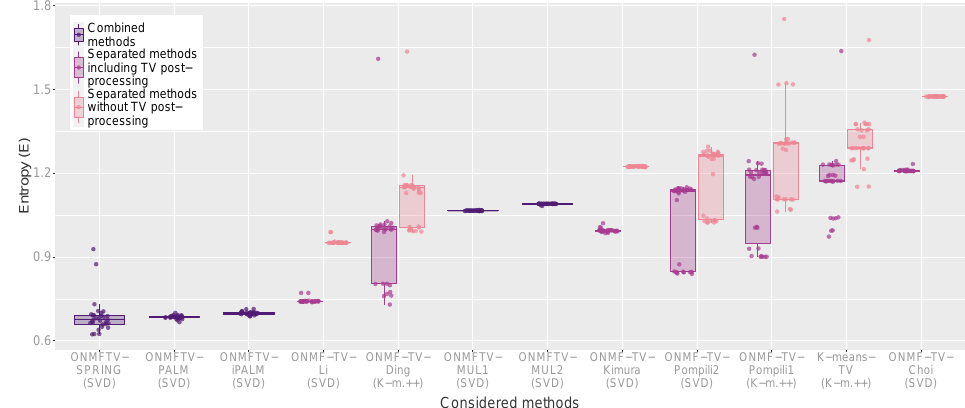
Figure 5. Box plot of the Entropy (E) of all performed